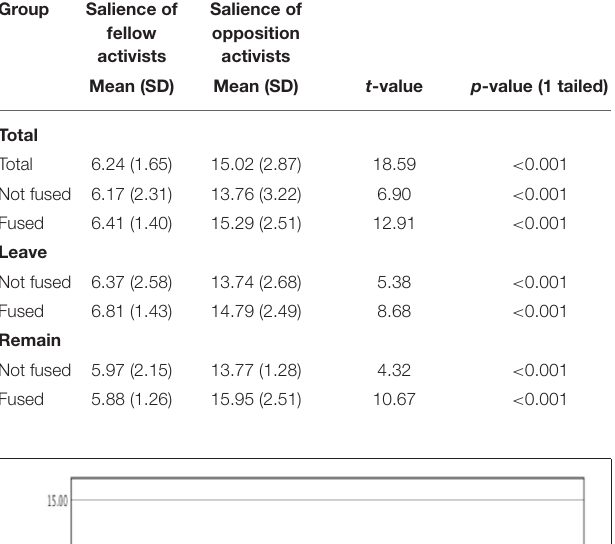
TABLE 3 | Salience of fellow and opposition activists by group and fusion category. Group